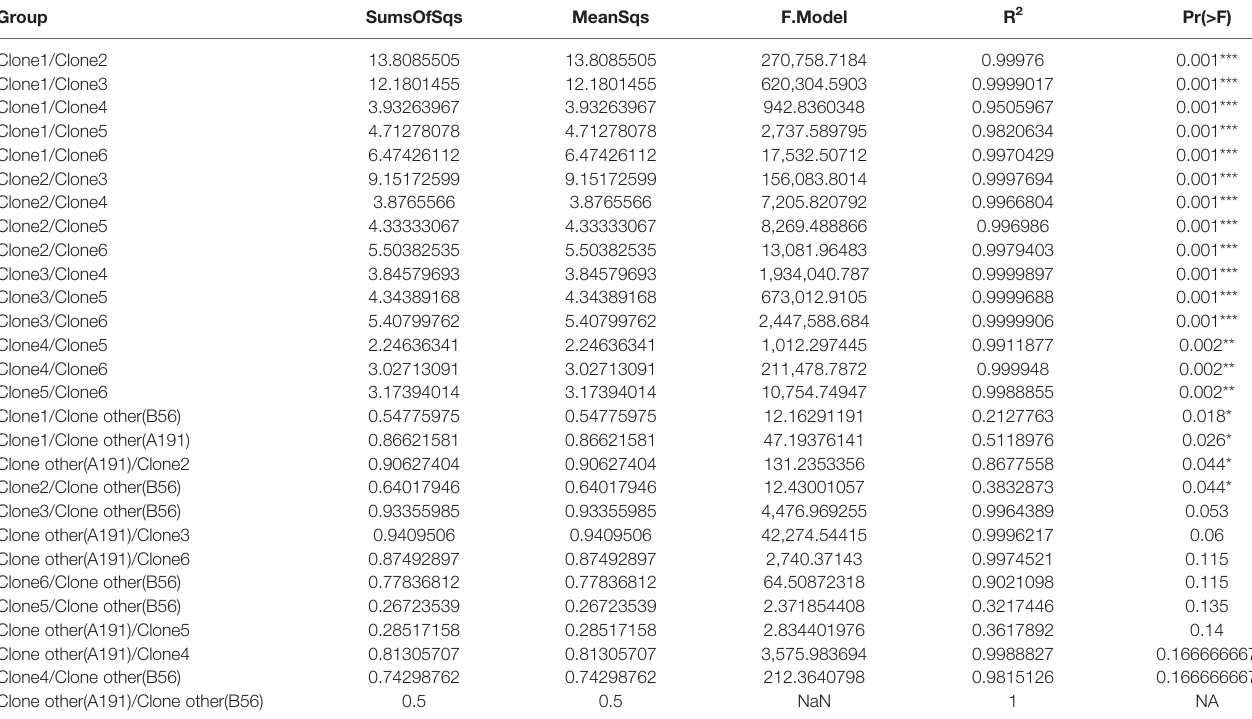
TABLE 1 | Results of permanova variance analysis among clonalities based on SNP distance (permutation = 10,000). Group SumsOfSqs MeanSqs